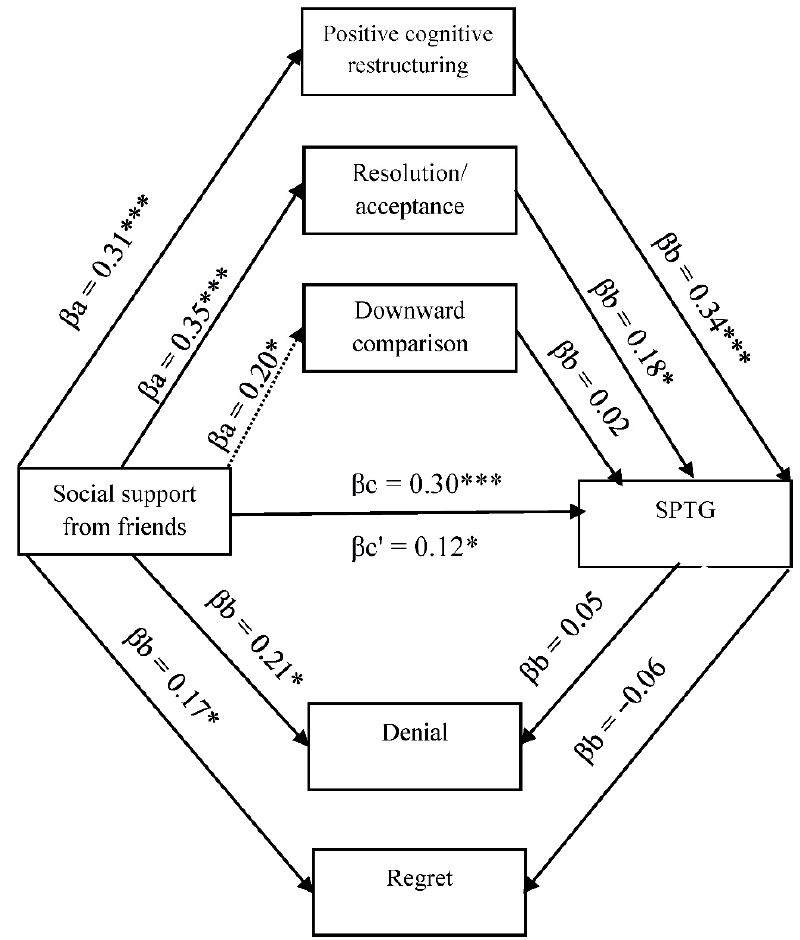
Figure 4. Model of relations between social support from friends, cognitive processing of trauma and secondary posttraumatic growth. β a,b—indirect effect; β c—total effect; β c’—direct effect. * p < 0.05; *** p < 0.001.